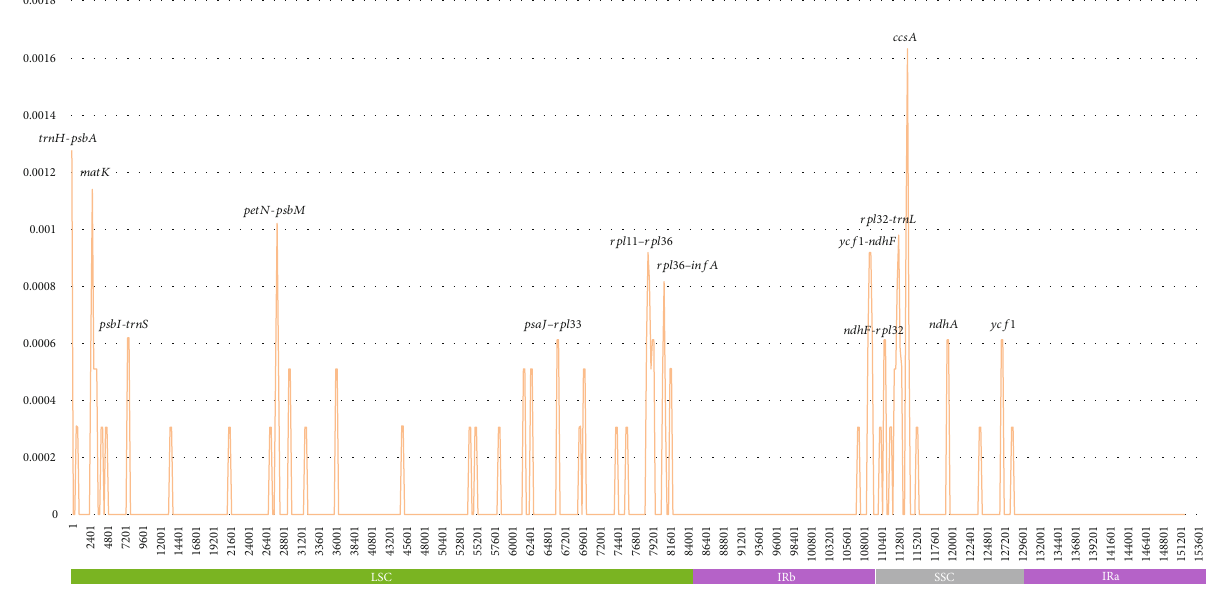
Figure 3: Nucleotide diversity of the seven Chenopodium album chloroplast genomes. The X -axis presents coordination of chloroplast genome, and the Y -axis presents values of nucleotide diversity value of 500bp window sliding by 200 bp step. Highest peaks of the nucleotide diversity graph display the name of genic regions. Green, pink, and grey bars below the X -axis indicate the LSC, IR, and SSC regions, respectively. Table 5: List of normal SSRs of six Chenopodium album